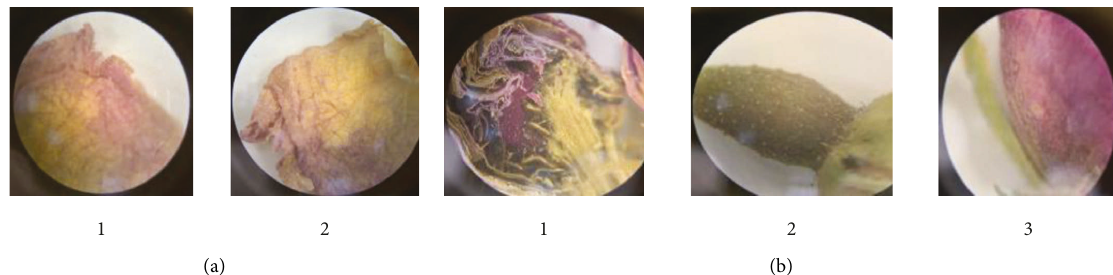
Figure 1: Macroscopic analysis of R. damascena using binocular: (a) flower petals; (b) buds.